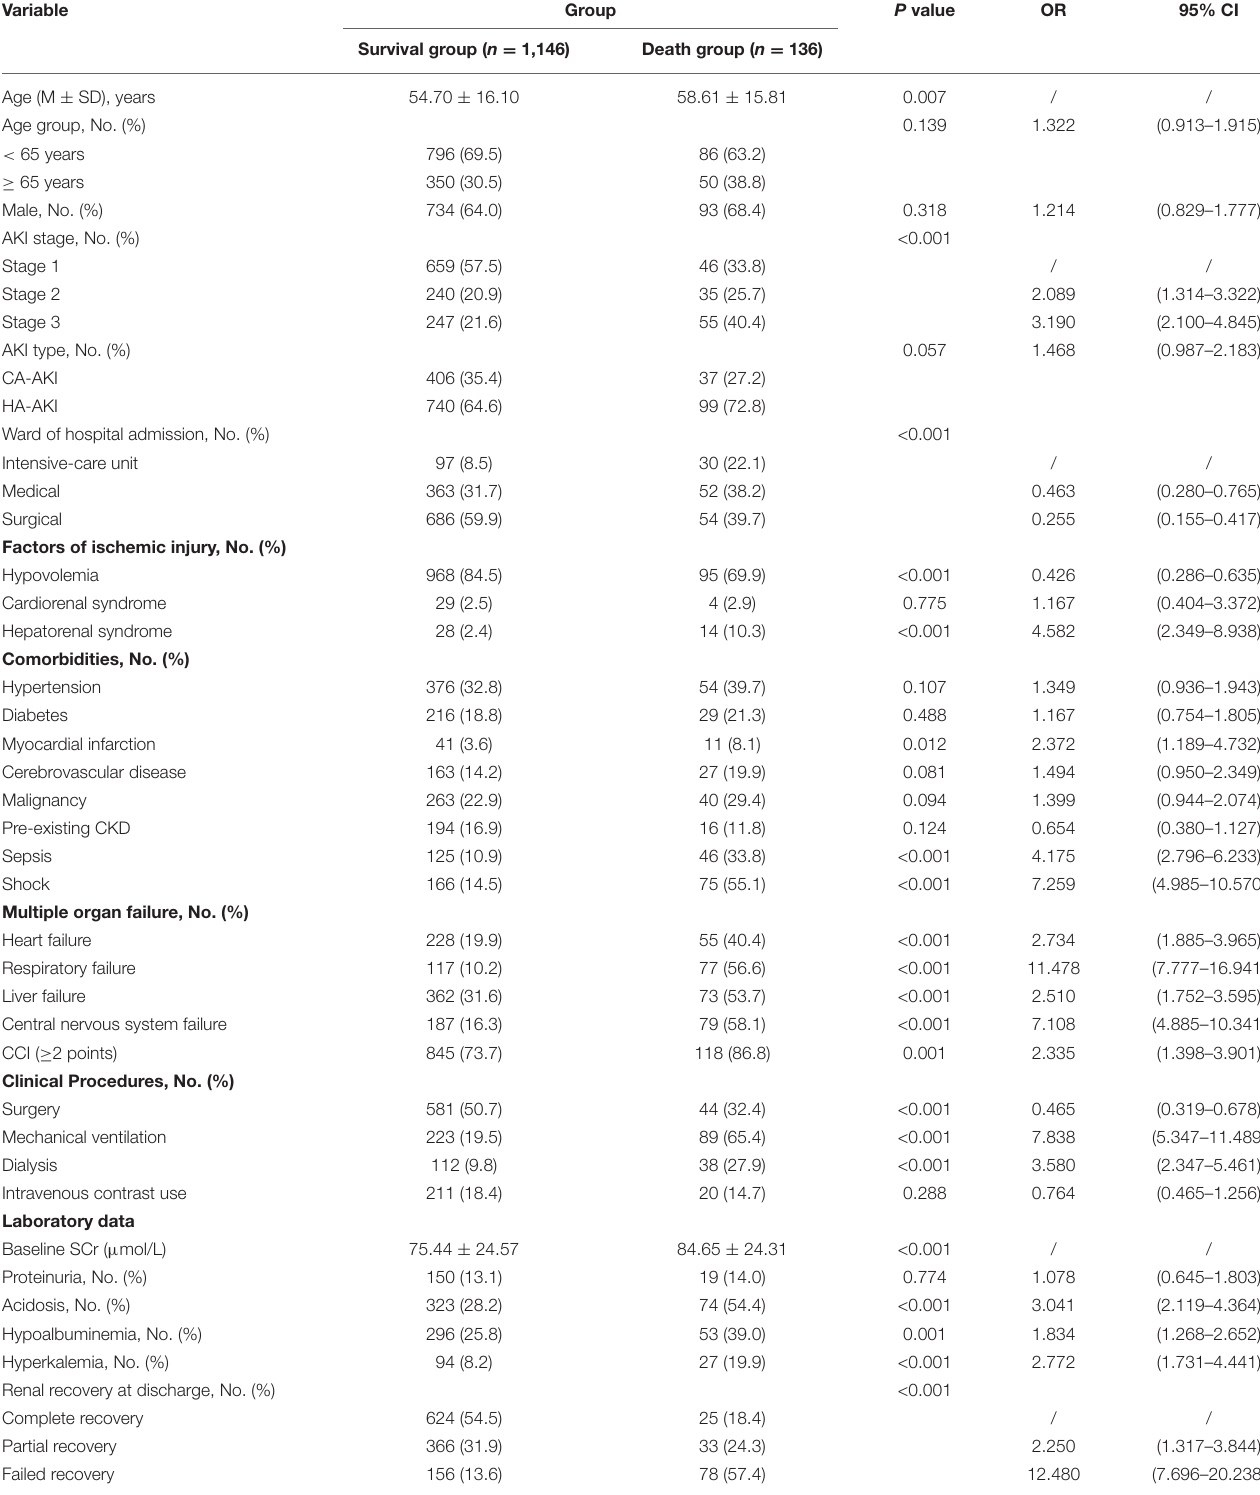
TABLE 2 | Characteristics of the study population stratified by 30-day survival status in the training cohort.